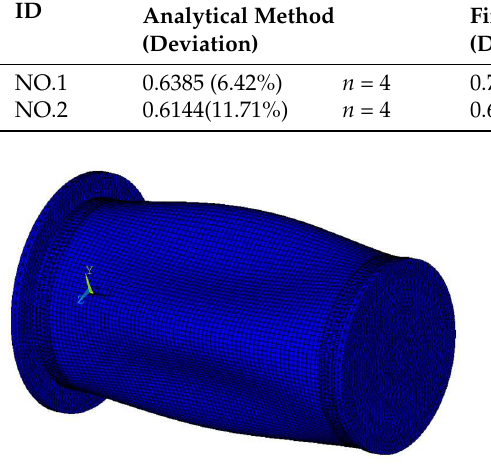
Figure 6. Buckling mode of shell NO.2.